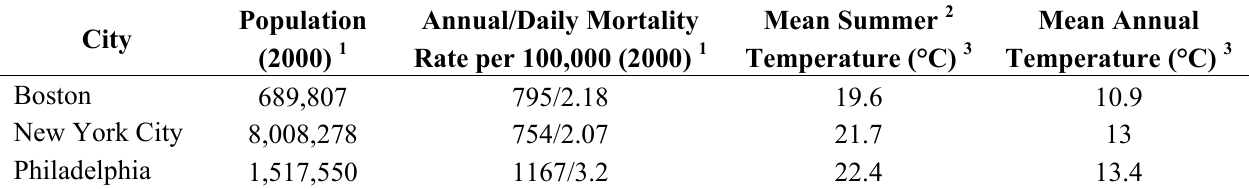
Table 1. Population, mortality and temperature statistics for Boston, New York City and Philadelphia.